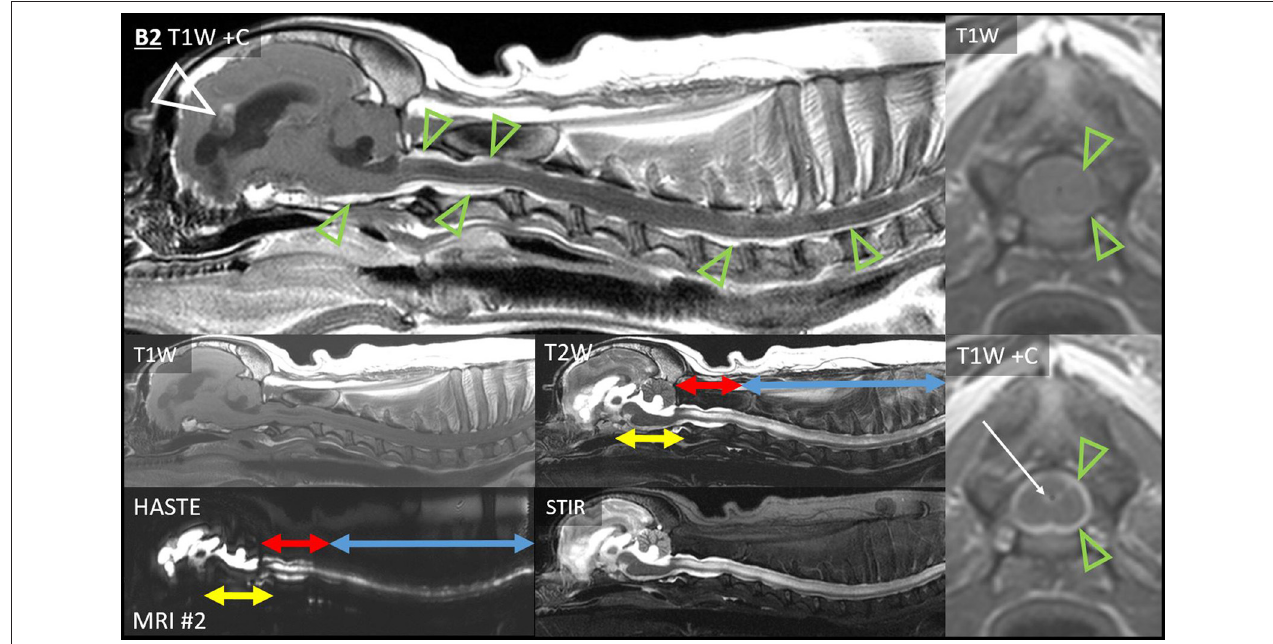
FIGURE 7 | Extensive leptomeningeal dissemination and generalized hydrocephalus, Case B2. Sagittal images of the brain and cervicothoracic spinal cord: T1W pre- and post-contrast, T2W, HASTE, and T2W-STIR. Normal CSF cannot be visualized ventral to the brainstem or in the cervical SAS. Note the lack of normal SAS on HASTE combined with the lack of normal epidural fat on T1W pre-contrast. Yellow double-headed arrows: CSF ventral to brainstem is irregular and hypointense to normal CSF on T2, STIR, and HASTE. Red double-headed arrows: within C1–C2, an irregular SAS can be identified on HASTE but not on T1, and it is strongly contrast-enhancing. Blue double-headed arrows: cervicothoracic SAS is difficult to identify on HASTE and contrast-enhancing. Narrow T2-hyperintensity dorsal and ventral to the spinal cord does not suppress on STIR and is not evident on T1W pre-contrast, suggesting it is composed of CSF with attenuation of epidural fat. There is widespread thick, strong leptomeningeal contrast enhancement (green arrowheads), including ventral to the brainstem and C1–C2, and dorsally from the obex to C1–C2. Caudal to C2, strong leptomeningeal enhancement was particularly evident on transverse images. T1W pre- and post-contrast transverse images, level of C3: normal epidural fat is barely discernible. There is thick, strong leptomeningeal contrast enhancement (green arrowheads), ependymal enhancement (white arrow), and intramedullary mass effect. There is severe ventriculomegaly of all ventricles, with partial volume averaging of the rostral horn lesions and the falx cerebri. Irregularly contrast-enhancing primary intra-axial mass bulges into the lateral ventricle (white